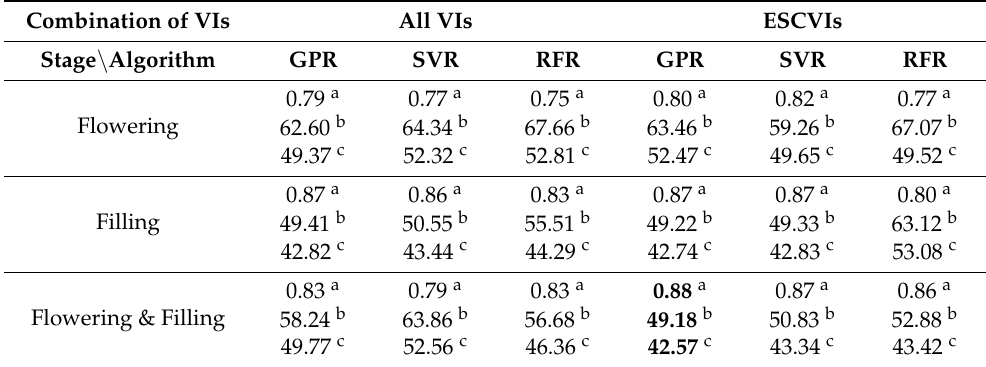
Table 2. R 2 , RMSE and MAE of the six yield models constructed with different combinations of the VIs at the flowering, filling and flowering and filling